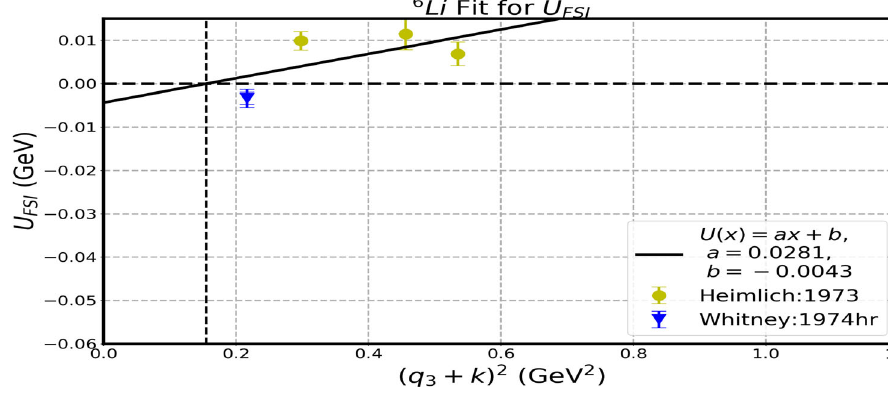
= 0 . 275 GeV) and one 197 Pb ( k P F 82